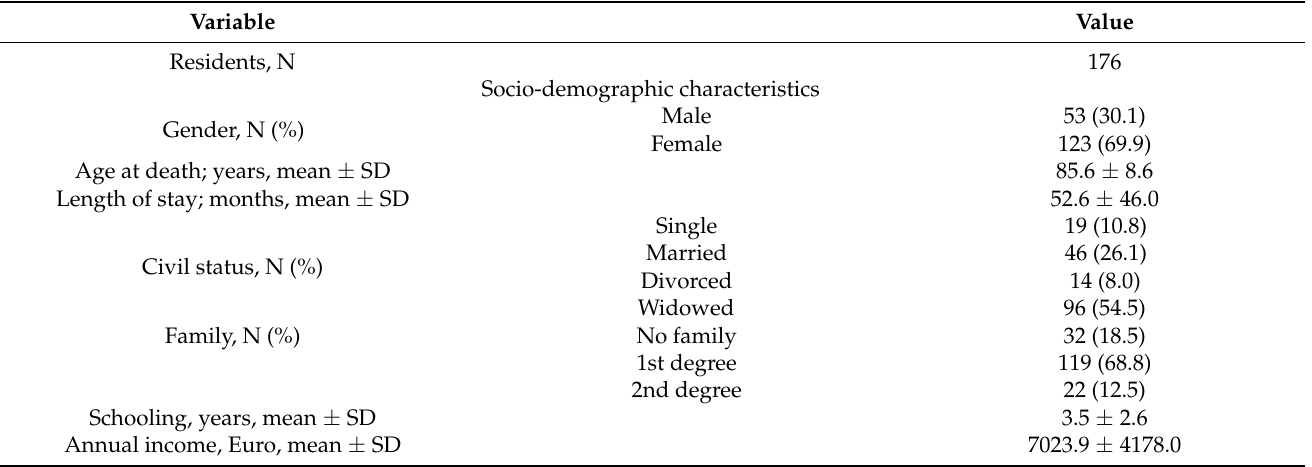
Table 1. Socio-demographic and clinical characteristics of the NH Residents. N—number; SD—standard